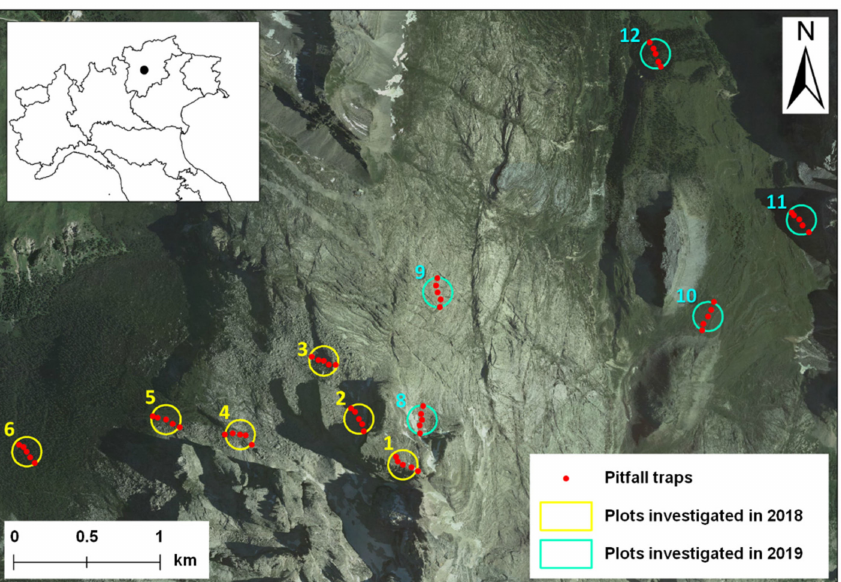
Figure 1. Study area located in the Adamello-Brenta Natural Park, Western Dolomites, Italian Alps (46 ◦ 11 (cid:48) 1.94 (cid:48)(cid:48) N, 10 ◦ 54 (cid:48) 2.41 (cid:48)(cid:48) E; in black in the left panel) with the 11 investigated plots and the 55 sampling points (pitfall